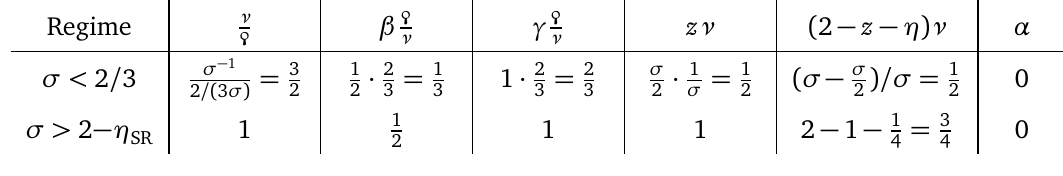
Table 3: Analytical values in the limiting regimes for the exponents that are directly accessible by the methods presented in Sec.